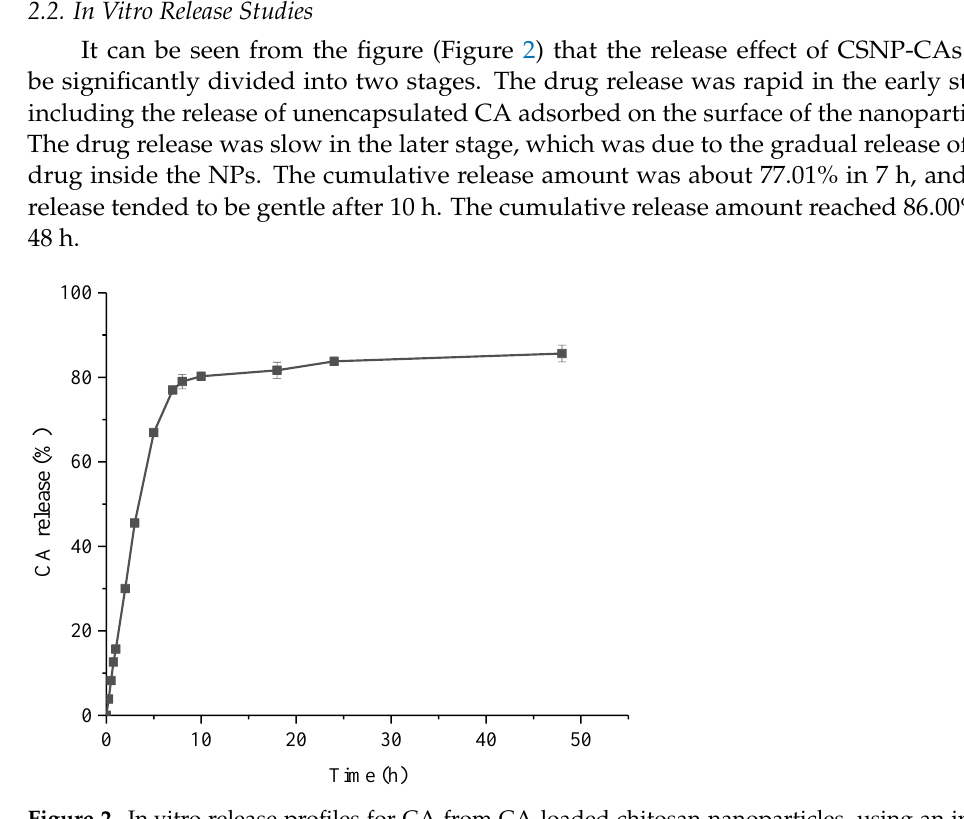
Figure 2. In vitro release profiles for CA from CA-loaded chitosan nanoparticles, using an initial weight ratio of chitosan to CA of 4:1. Data are presented as means ± SDs, n = 3.